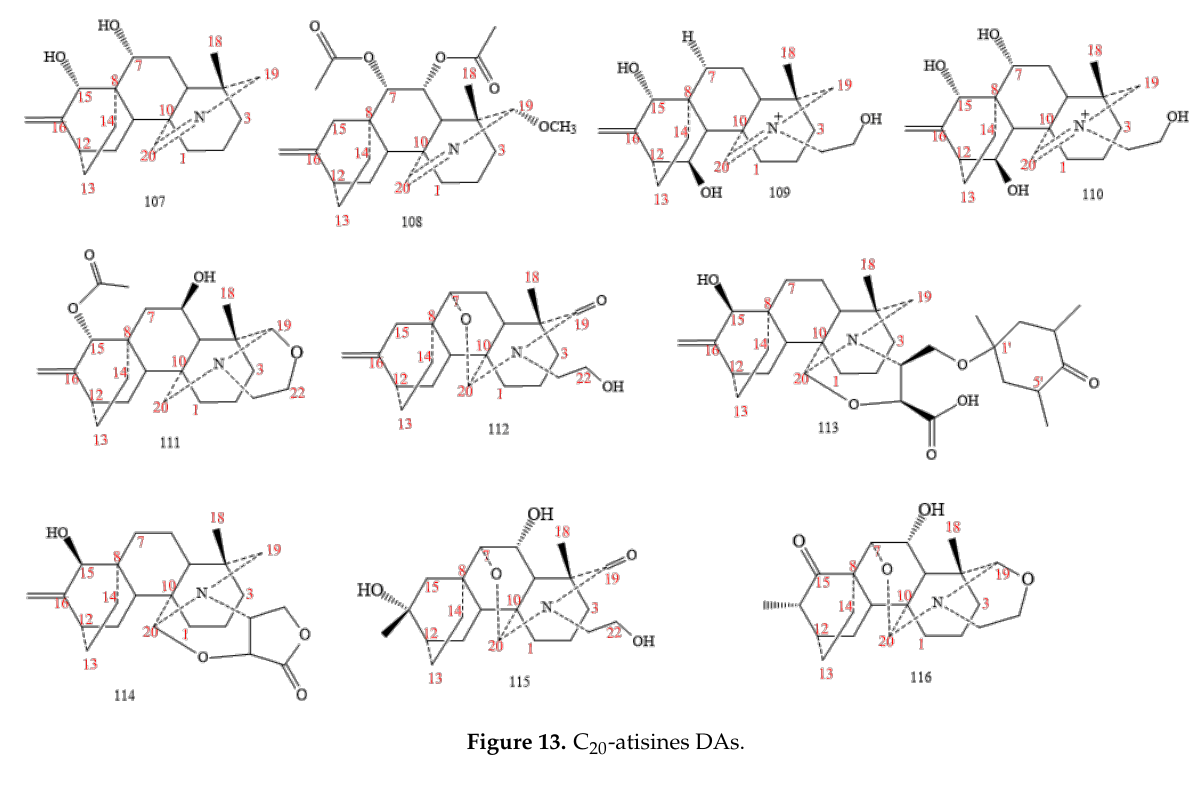
Figure 13. C 20 -atisines DAs.